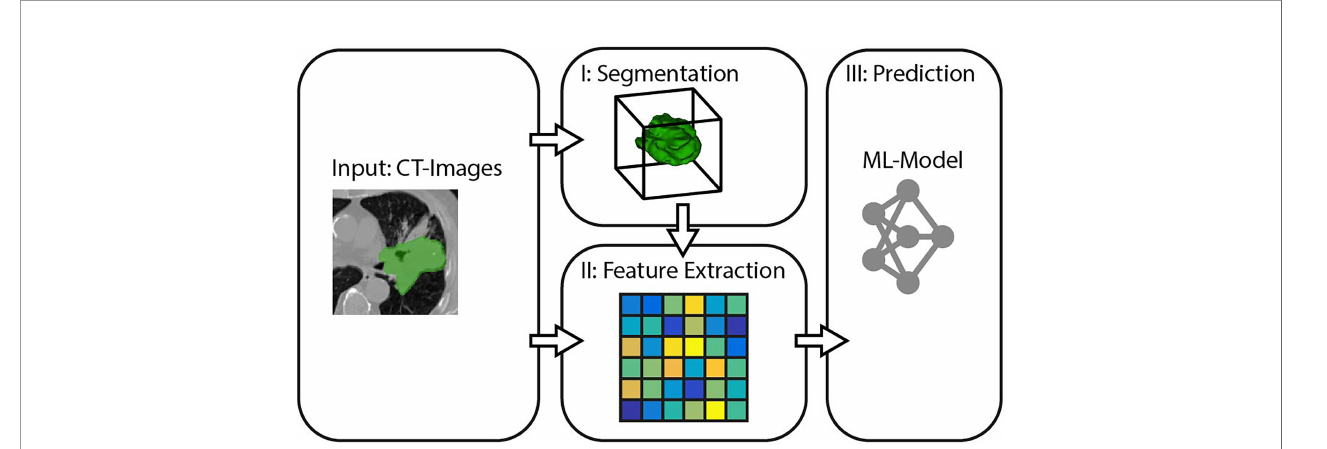
FIGURE 1 | General pipeline for survival rate